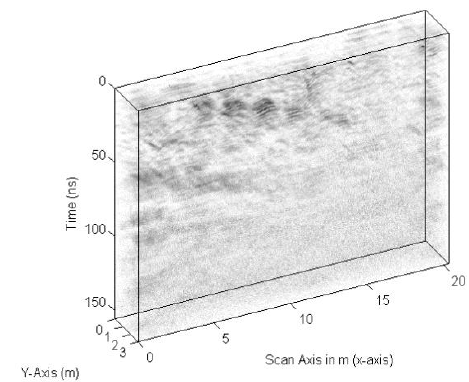
Figure A2. Processed MALA Imaging Radar System (MIRA) radar data over the Forest Lodge test site.